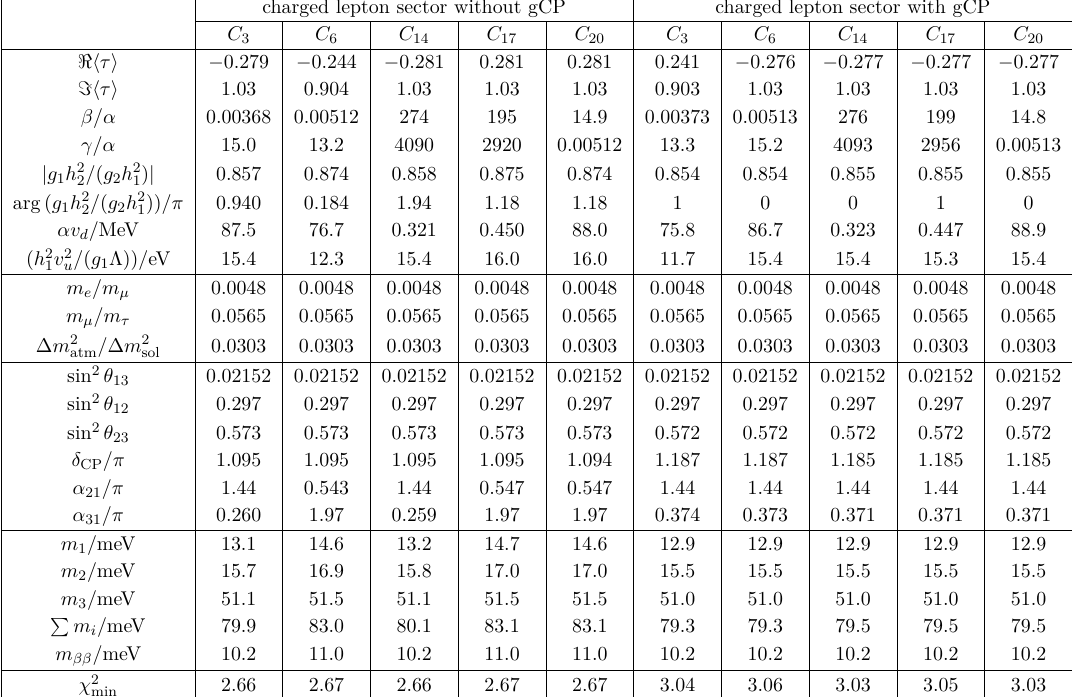
Table 4 . The best fit results for lepton masses and mixing parameters in the five phenomenologi- cally viable models of type II models, where both scenarios with gCP and without gCP symmetry are